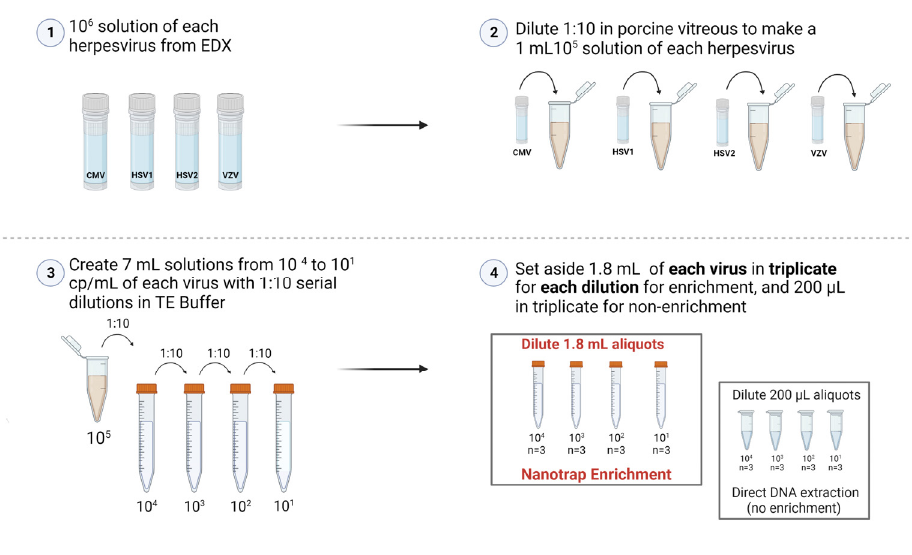
Figure 1. Creating simulated vitreous samples. The serial dilution process to prepare samples to be either enriched with Nanotrap Red particles or not enriched (Created with BioRender.com).